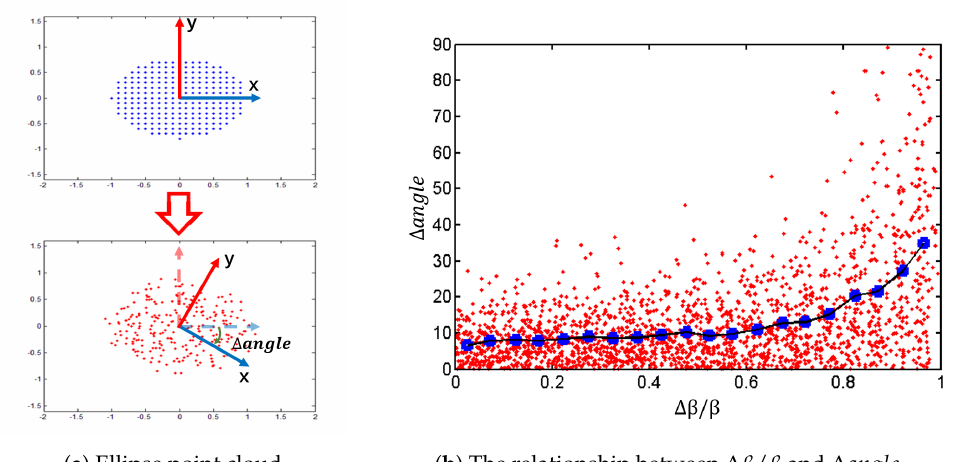
Figure 1. The experiment on ellipse distributed point data. ( a ) The blue and red point data represent the elliptical point data before and after the addition of noise. ( b ) The red and blue points represent the data distribution and the average,